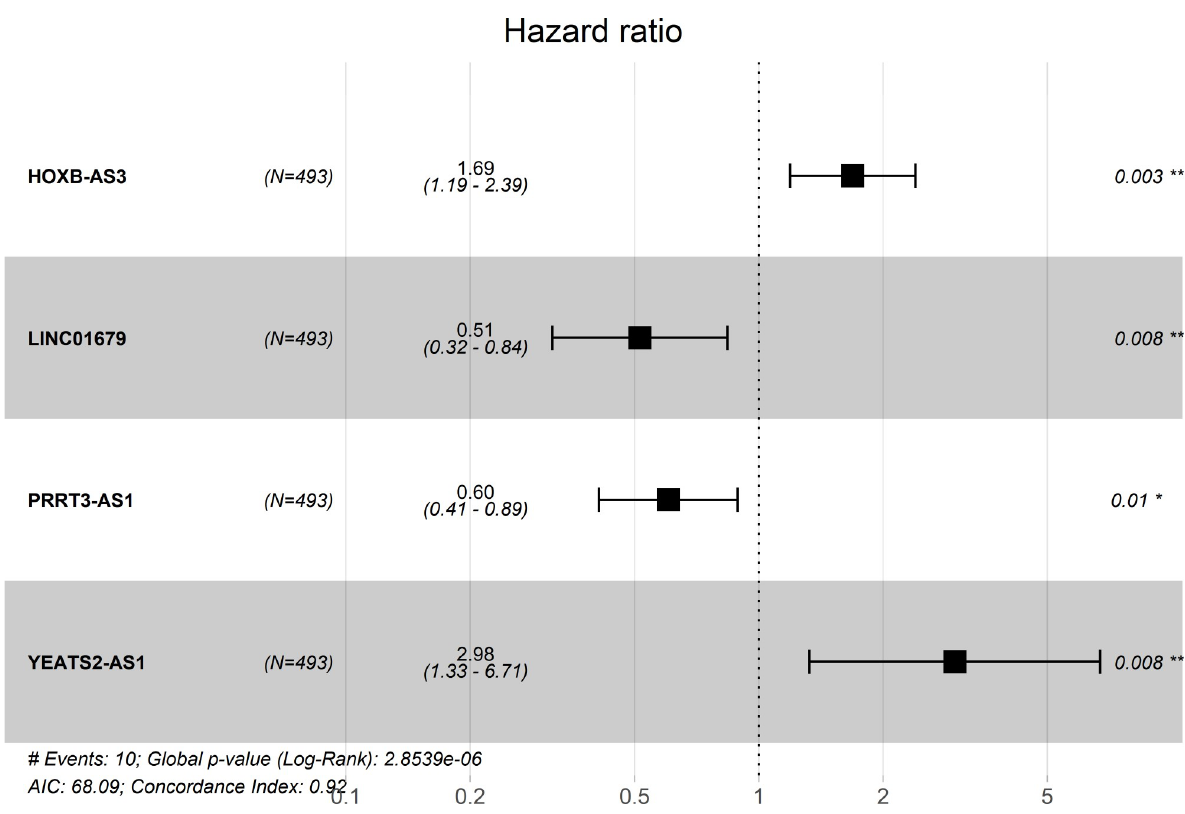
Fig 3. Four lncRNAs Forest map formed by multivariate Cox regression analysis.